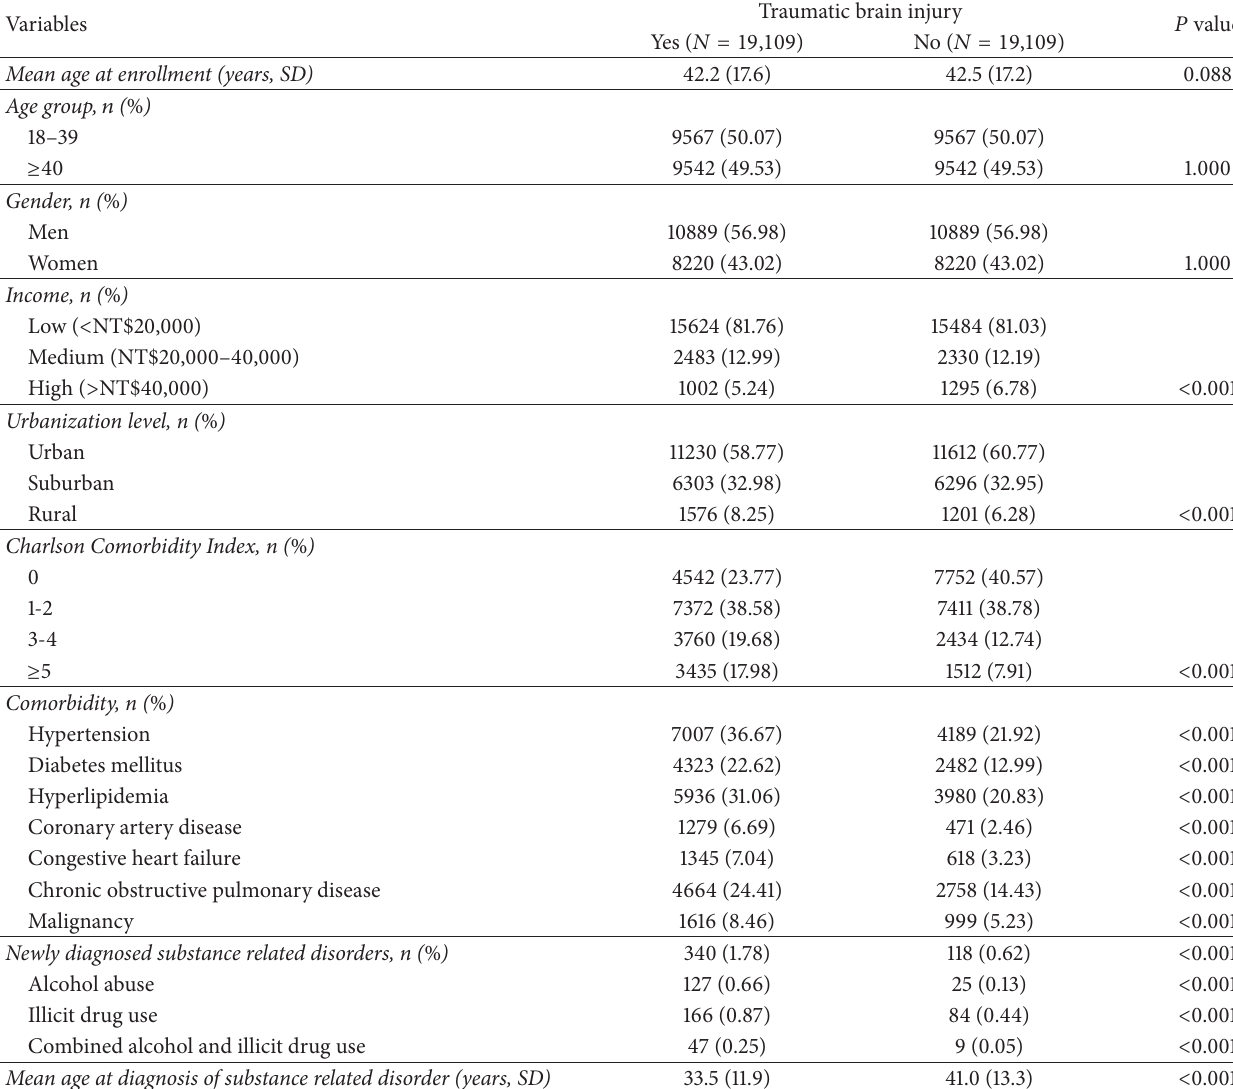
Table 1: Baseline characteristics of patients with and without traumatic brain injury.